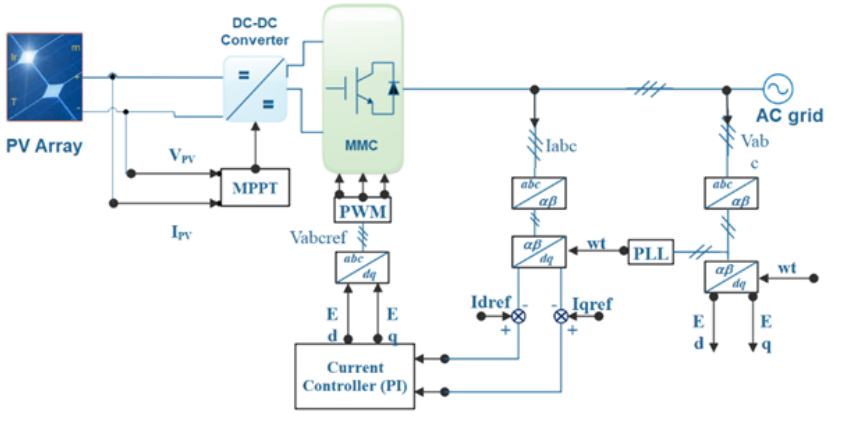
Figure 7. Control block diagram.